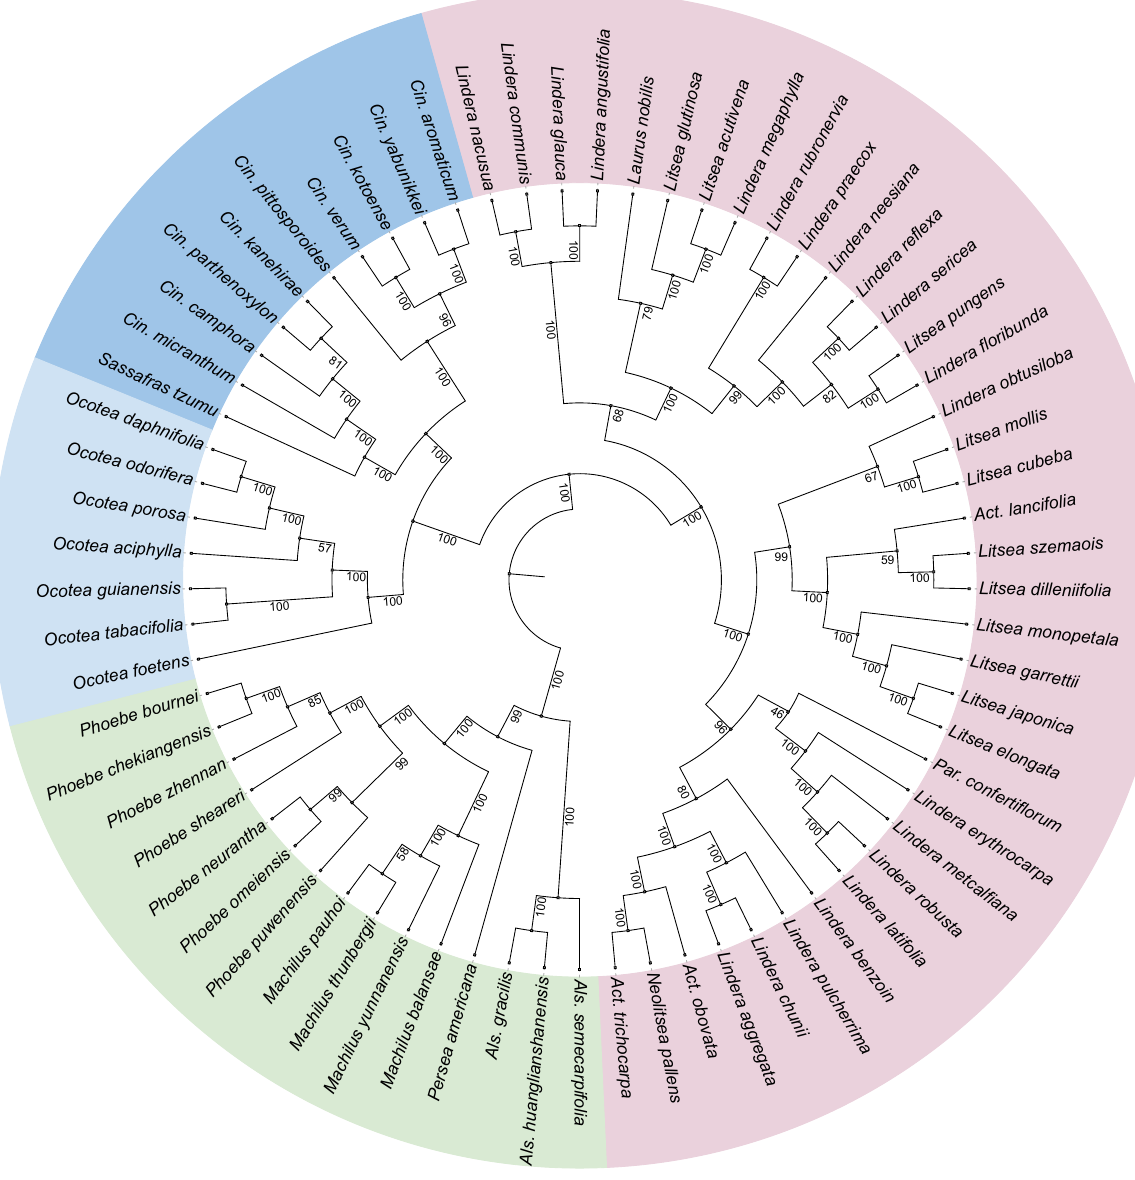
Figure 7. Maximum Likelihood phylogeny including 69 complete chloroplast genome sequences of Core Lauraceae. Color codes: blue—Cinnamomeae, incl. pale blue for Ocotea spp.; pink—Laureae; green—Perseeae. Maximum likelihood bootstrap support values (ML-BS) are shown next to the